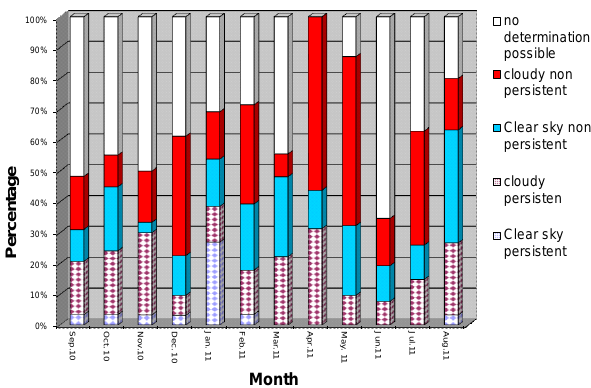
Figure 3. For each month the percentage of days with and with- out contrail persistence are shown. Many days (upper part of the columns referred to as “no determination possible”) mostly with full cloud cover do not allow a determination as to the persistence of contrails. The red and blue parts of the columns are cloudy (“cloudy non persistent”) and clear sky (“clear sky non persistent”) days without contrail persistence, whereas the two lowest partitions of the columns show days with contrail persistence under cloudy (“cloudy persistent”) and clear sky (“clear sky persistent”) condi-